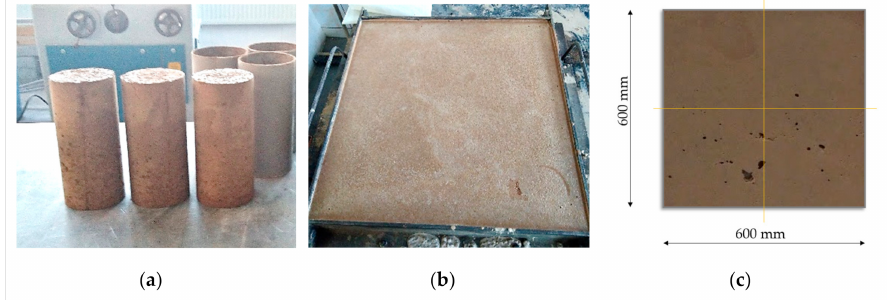
Figure 2. Cylinders ( a ); plate ( b ); how the plate was cut in 4 pieces ( c